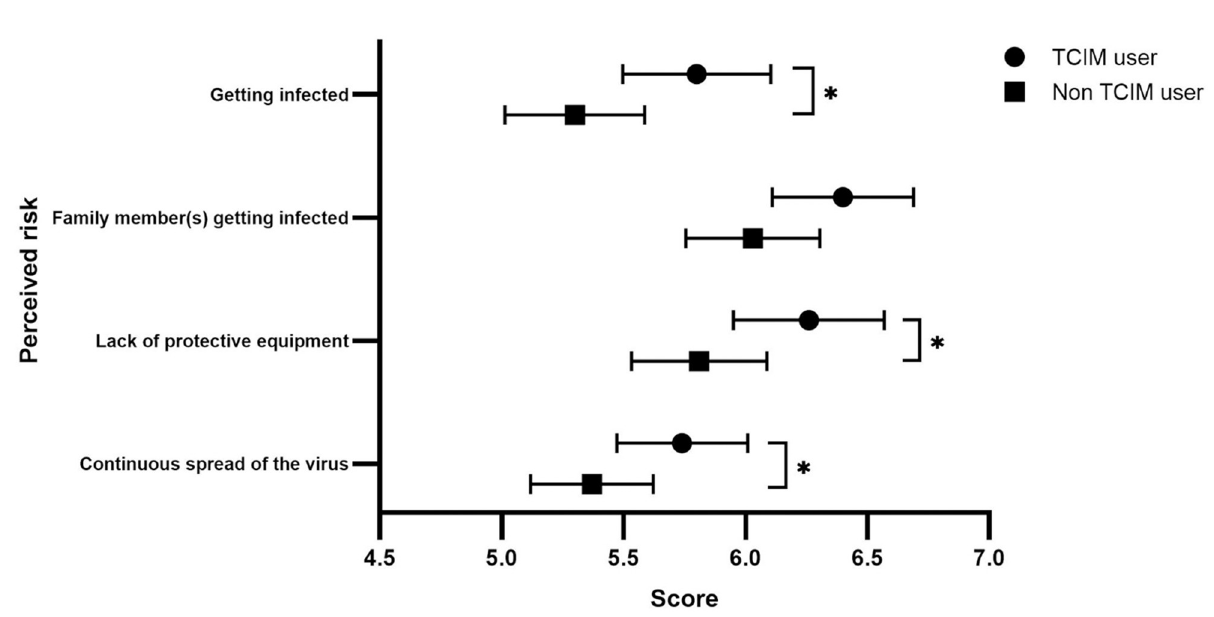
Fig 2. Risk perception score of COVID-19 among the respondents. a The risk perception scores were compared with Mann-Whitney U test. The scores are presented as mean with 95% confidence intervals. ( � p < 0.05) TCIM, Traditional, Complementary and Integrative